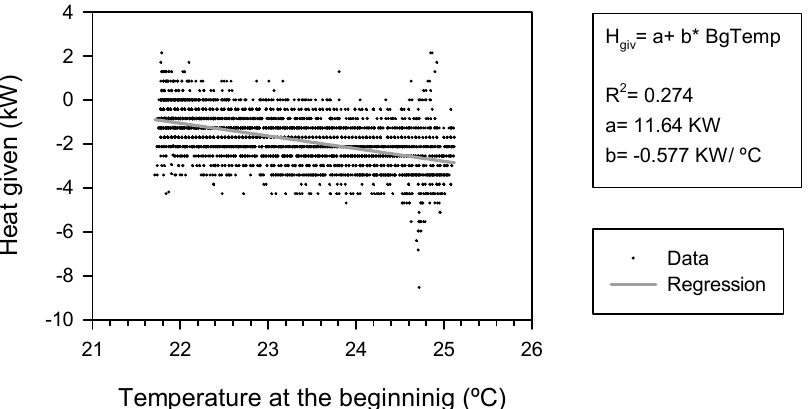
Figure A7. Correlation between the energy transference from the greenhouse circuit to the environment, and the temperature at the beginning of the water circuit.